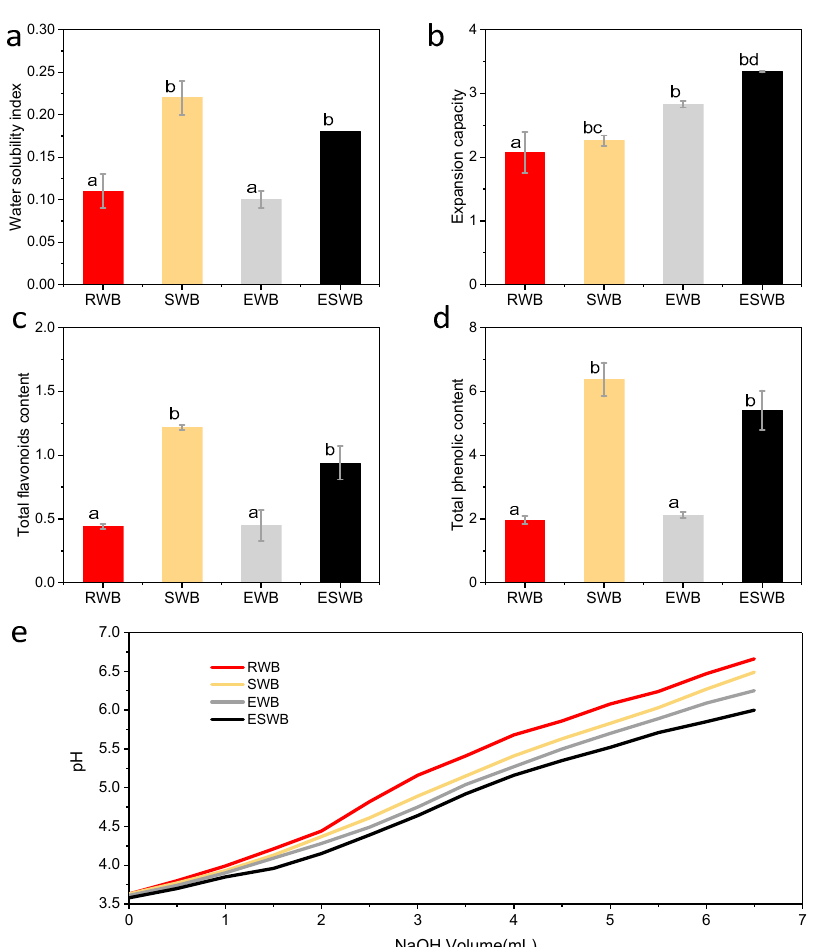
Figure 4. Water solubility index ( a ), expansion capacity ( b ), total flavonoid ( c ) and phenolic ( d ) contents, as well as cation exchange capacity ( e ) of raw wheat bran (RWB), steam-exploded wheat bran (SWB), extruded wheat bran (EWB), and extruded steam-exploded wheat bran (ESWB); means that are significantly different ( p < 0.05) are indicated by different letters.